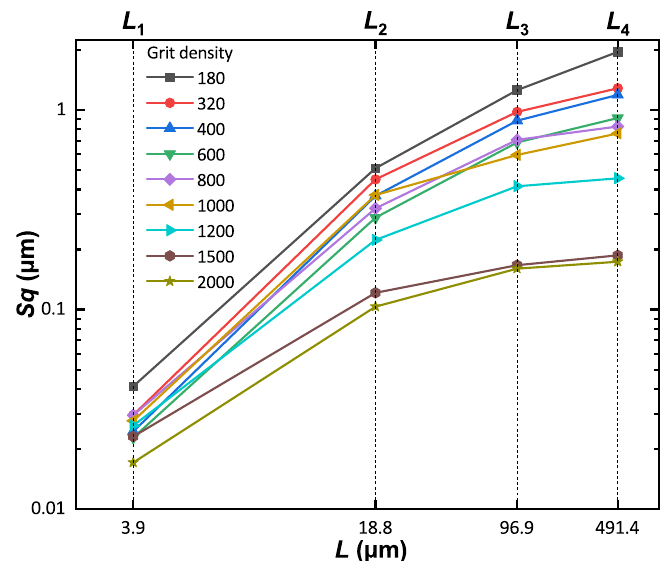
Figure 8. The relationship curves of Sq - L obtained by processing WLI data with the RSE